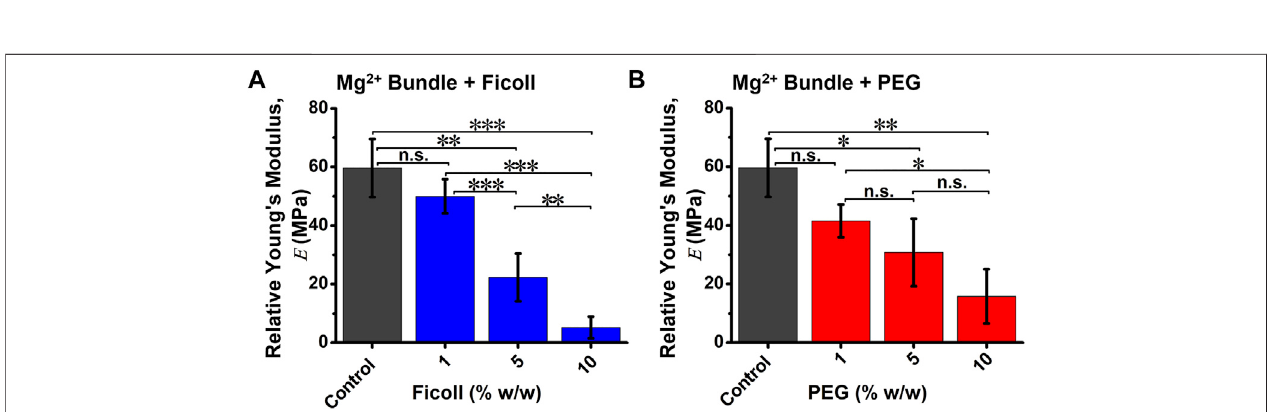
FIGURE 2 | The relative Young ’ s modulus ( E ) of cation-induced bundle in the absence and presence of varying macromolecular crowded environments. Quanti fi cation of average bundle E in (A) Ficoll (1 – 10% w/w) or (B) PEG (1 – 10% w/w) conditions. Cation-induced bundle E was fi tted using Hertz model, and signi fi cant difference to bundles was determined by Tukey test (n.s., not signi fi cant; * p < 0.05, ** p < 0.01, *** p < 0.001). Total number of force curves analyzed per condition N ≈ 150, and error bars indicate standard